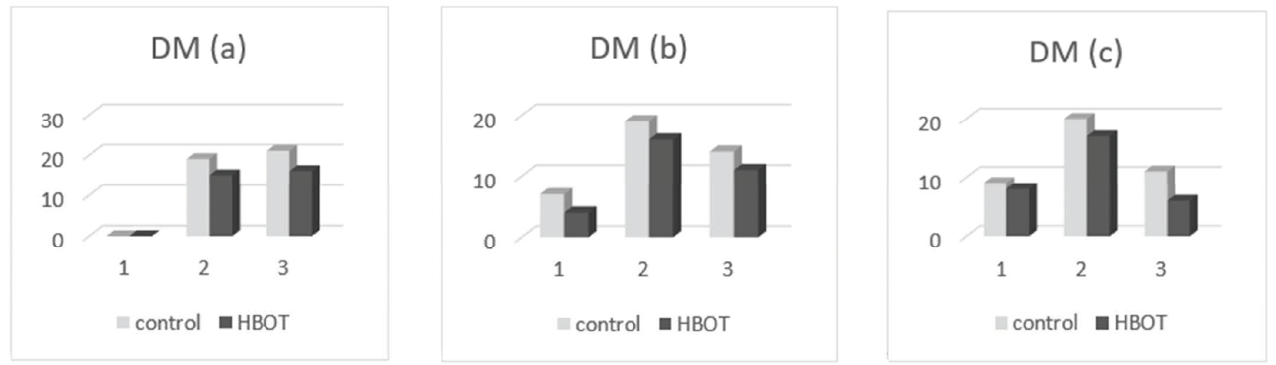
Figure 5. Patient distribution based on SB index at ( a ) first examination, ( b ) second examination, and ( c ) third examination.